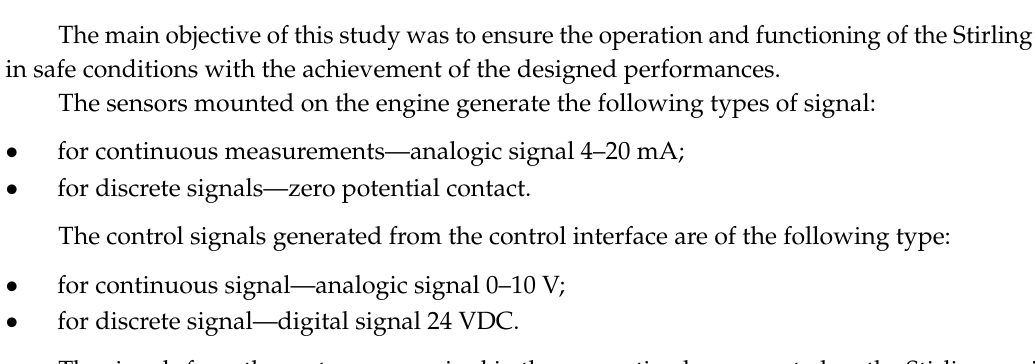
Figure 14. Positioning of temperature sensors on the primary exchanger.